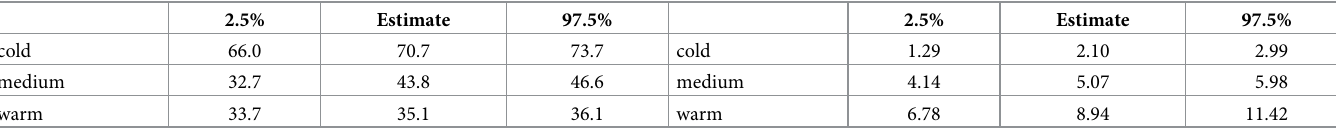
Table 2. Approximate 95% confidence intervals for peak location (left) and peak decrease (right). Units are hours after start of experiment and %/h, respectively. 2.5%